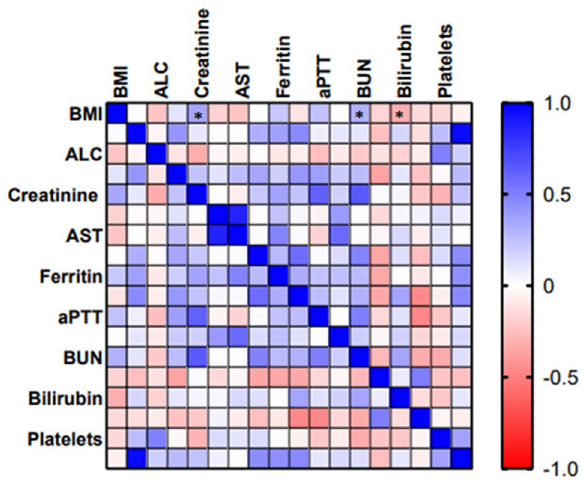
Figure 6. Correlation representation between BMI and blood biomarkers. A correlation plot showing that the BMI of the studied cohort and their clinical blood biomarkers. Pearson correlation coefficients with blue for positive correlation and red for negative correlation. * p <